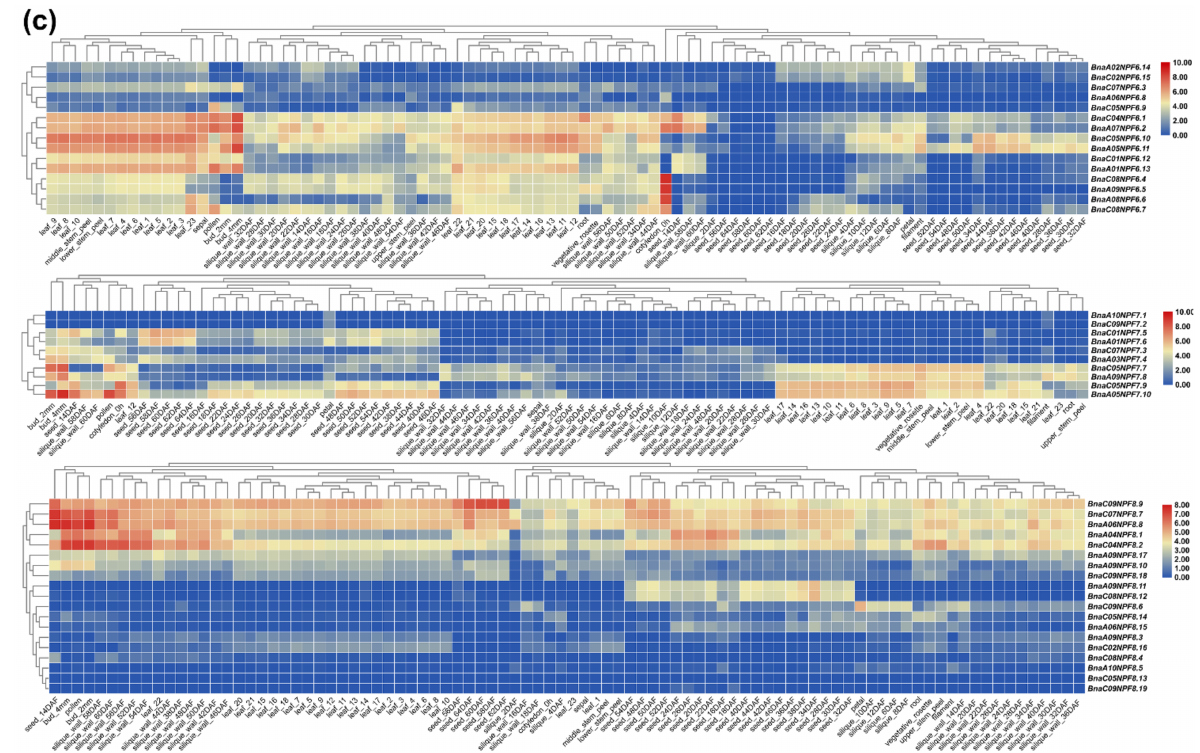
Figure 3. Gene expression profiles of NPF genes for 90 tissues or periods in B. napus . ( a – c ) display the gene expression profiles of NPF1–4 , NPF5 , and NPF6–8 genes, respectively. The word “DAF” and the number before it mean the days after flowering. The number following “leaf” means leaf in different growth stages and parts of the plant, which originates from the online website (http://yanglab.hzau.edu.cn/BnTIR/eFP, Accessed on 4 May